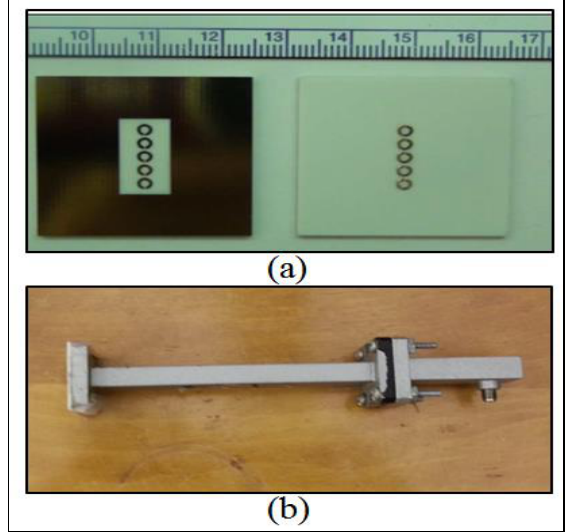
Figure 2. ( a ) Photographs of the front and back views of the split-ring resonator (SRR) array etched on a printed circuit board [6]; ( b ) Photograph of the